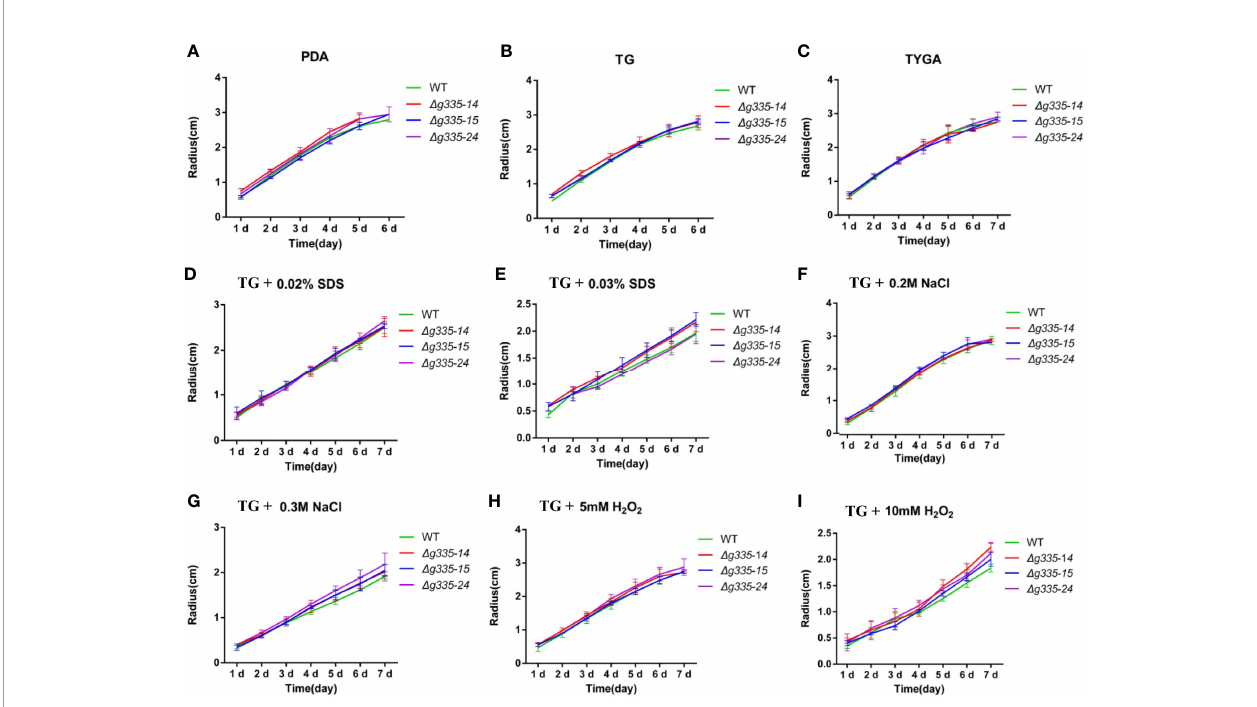
FIGURE 2 | Measurement of the hyphal growth of mutants under normal or stressful condition. (A – C) The hyphal growth rates of mutant and wild-type strain on PDA, TG, and TYGA media. (D, E) The hyphal growth rates of mutant and wild-type strain on TG medium containing 0.02% (D) , and 0.03% (E) sodium dodecyl sulfate (SDS). (F, G) The hyphal growth rates of mutant and wild-type strain on TG medium containing 0.2M (F) , and 0.3M (G) sodium chloride (NaCl). (H, I) The hyphal growth rates of mutant and wild-type strain on TG medium containing 5mM (H) , and 10 mM (Fig. I) hydrogen peroxide (H 2 O 2 ). WT, wild-type strain. D g335-14 , D g335-15 , and D g335-24 : AOL_s00004g335 knock-out